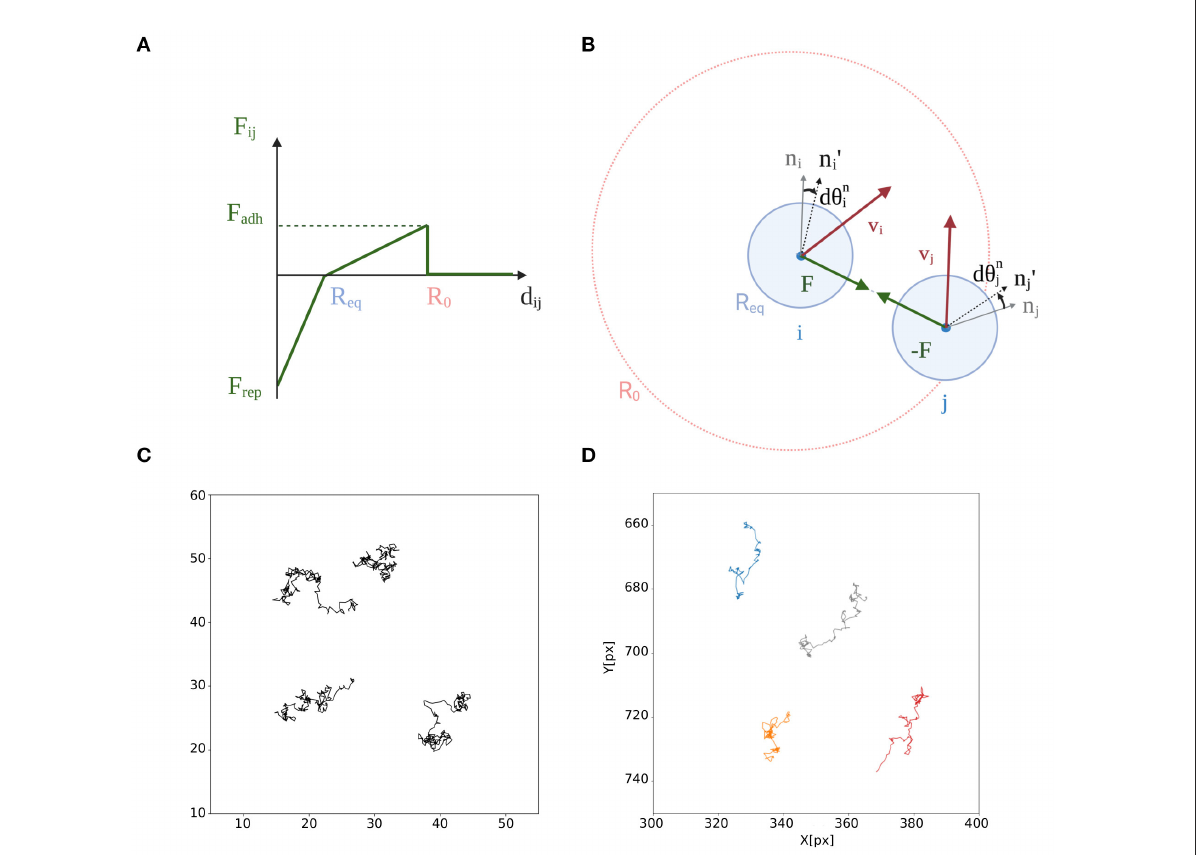
FIGURE1 Self-propelled particle model for migrating and interacting cells. (A) Finite-range interaction forces F( d ij ) between two particles of positions r i and r j and velocities v i and v j (accounting for both auto-propulsion and interaction forces, according to Equation 1) contribute to align n ′ i and n ′ j ( n ′ n ( t dt )), the direction of particles’ auto-propelled velocities. These forces only act when the Euclidean distance d ij = + for the definition of the other variables. (B) Radial component of the force between the two particles. When d ij < R eq , particle i exerts a strong repulsive force on particle j . Otherwise, within the range of interaction R 0 , the latter attracts particle j with a weaker elastic force, representing adhesion between different cells. (C) Typical trajectories of isolated particles during a simulation ( t f that, in the absence of interactions, follow a persistent random walk resembling that of Dictyostelium ’s single cells. (D) Trajectories of starved Dictyostelium cells recorded every 30 s during 1